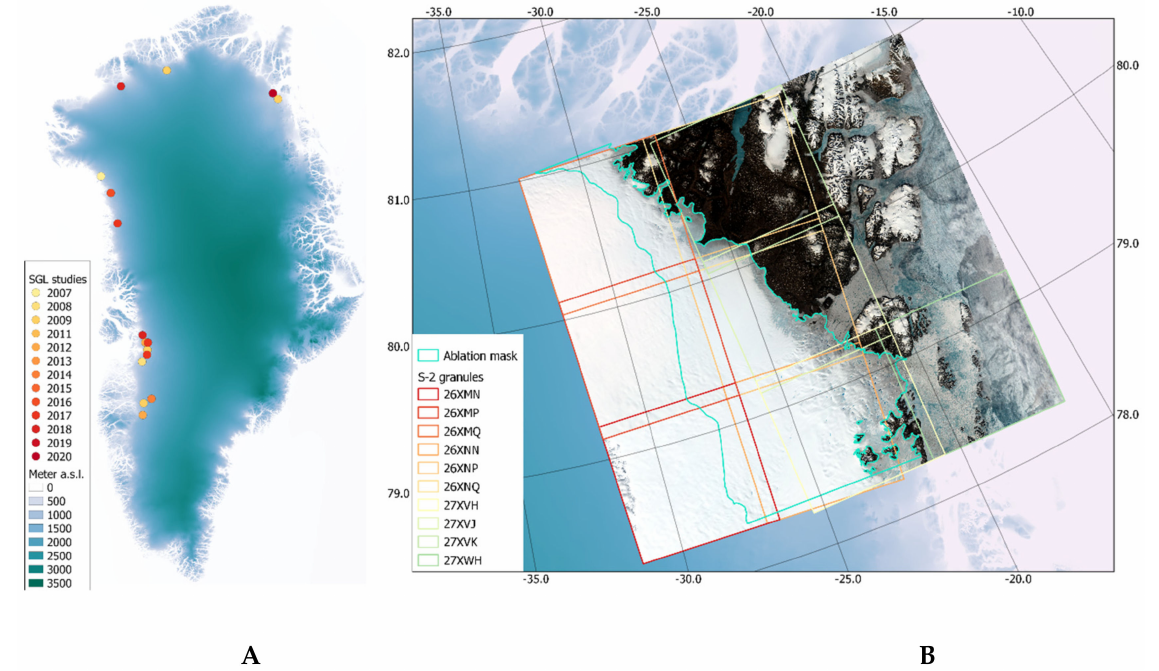
Figure 1. ( A ): Overview of SGL studies on Greenland between 2007 and 2020 [5,13,15–28]. Studies are color-coded by the year of publication. In case no exact coordinates were given in the respective study or a large area was monitored, the point was approximated to the center of the area of interest. In the case of multiple publications of the same first author for the same area of interest, only the first publication is shown. Studies covering the whole ice sheet, e.g., [29], are not shown. ( B ): Area of this study with footprints of the S-2 granules and the ablation mask used. True-color image is a 4–3–2 band mosaic of 19 June 2019. Background elevation model: Greenland Ice Sheet Mapping Project (GIMP)